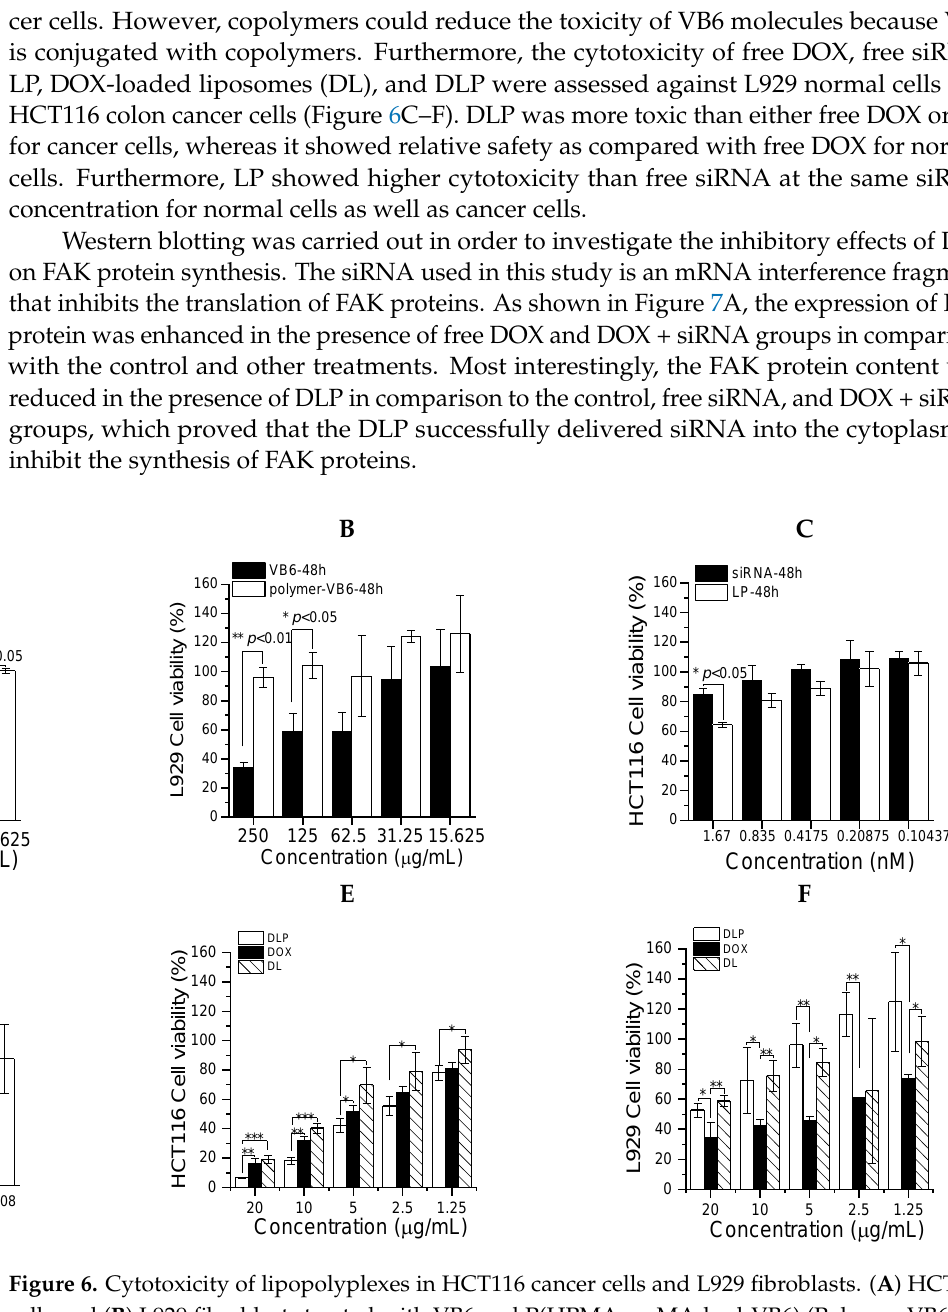
0.07 Figure 7. Bio-activity of lipopolyplexes. ( A ) Western blotting of HCT116 cancer cells after treating with each sample for 24 h. FAK/β -Tubulin ratio was calculated using imageJ software. ( B ) Cell cycle analysis of PI-stained HCT116 cancer cells. Cells were incubated with each sample for 24 h. DOX: